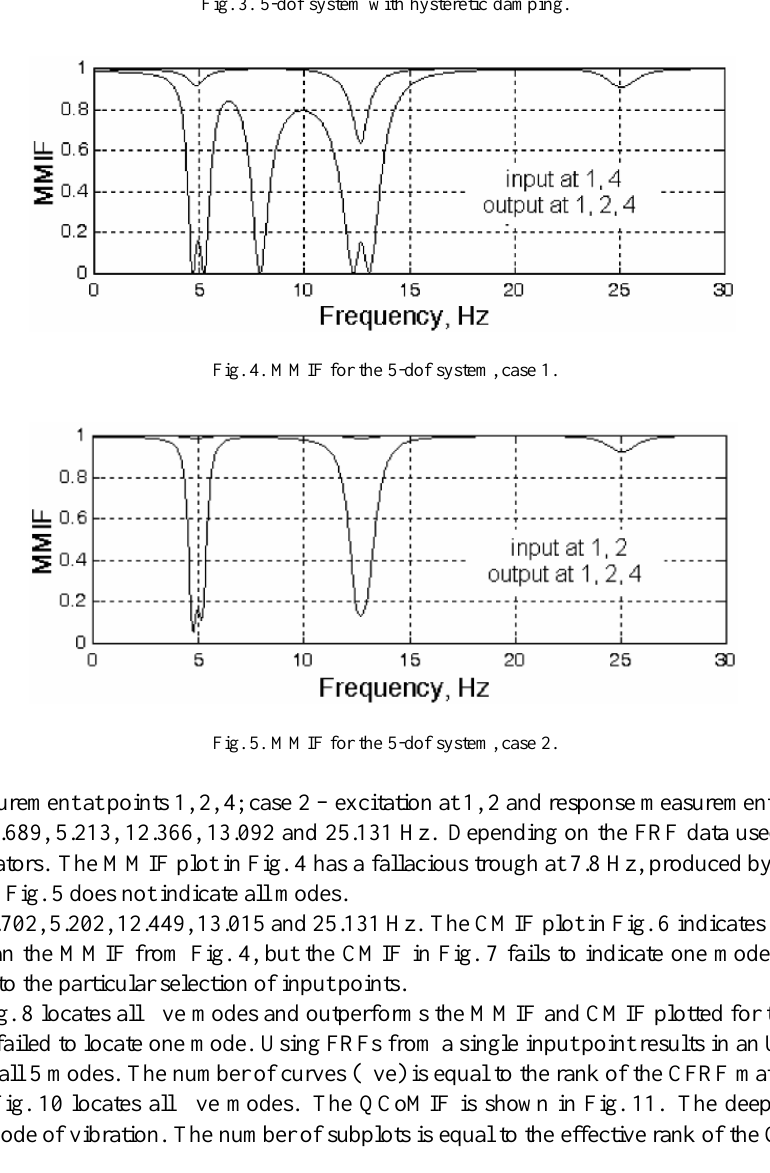
Fig. 3. 5-dof system with hysteretic damping.